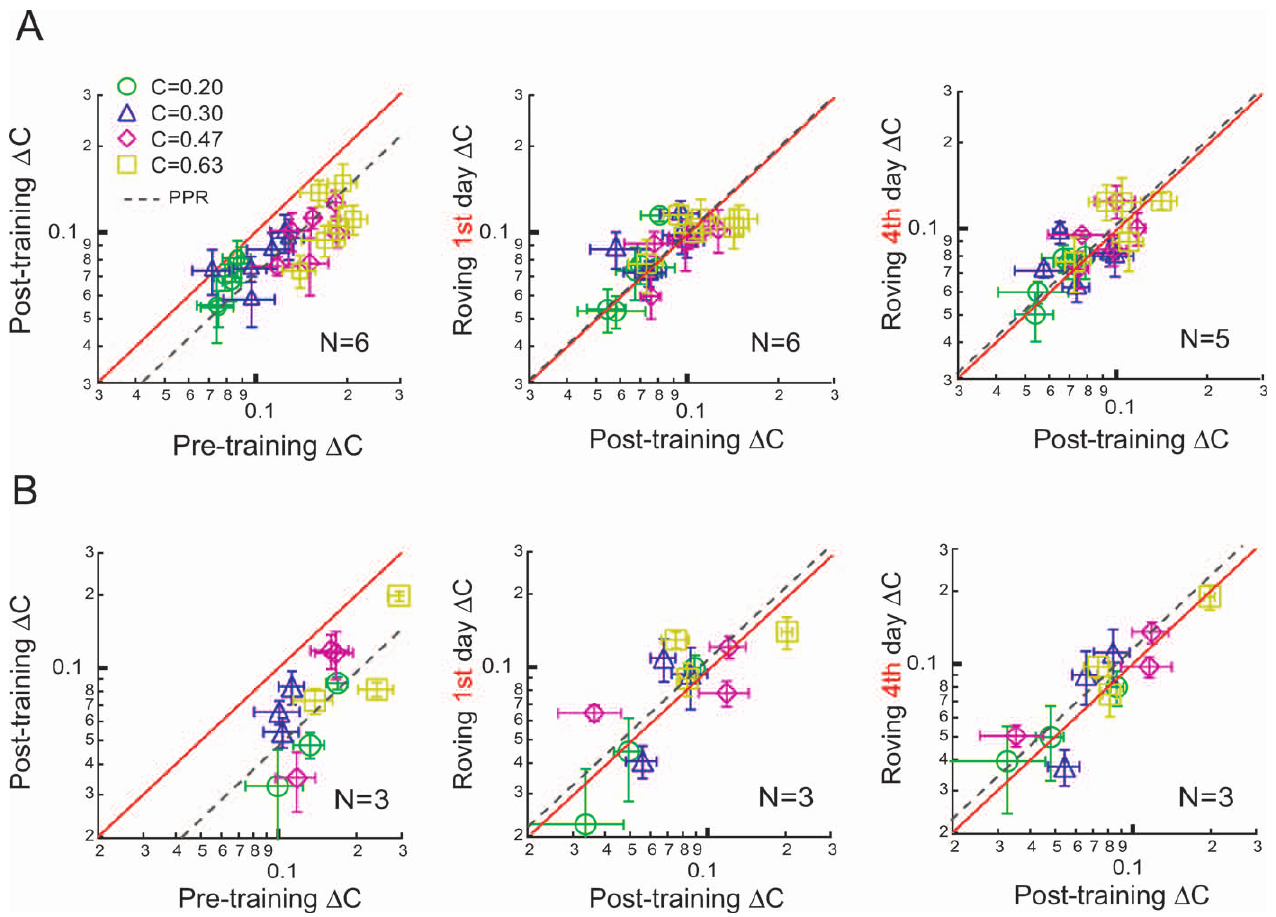
Figure 3. The Effects of Stimulus Roving After Learning (A) Stimulus roving immediately after completion of temporal-patterned training. The left panel shows pre- versus post-training thresholds. The middle panel shows first roving session versus post-training thresholds ( F 1,5 ¼ 0.24, p ¼ 0.647). Notice that the y -axis in the left panel becomes x -axis in the middle and right panels. The right panel shows the fourth (last) roving session versus post-training thresholds ( F 1,4 ¼ 0.49, p ¼ 0.520; only five observers finished all four roving sessions). (B) Same as (A) except that roving sessions started 2–4 wk after temporal-patterned training. The left panel shows pre- versus post-training thresholds. The middle panel shows first roving session versus post-training thresholds ( F 1,2 ¼ 0.46, p ¼ 0.570 ). Notice that the y -axis in the left panel becomes x -axis in the middle and right panels. The right panel shows the fourth (last) roving session versus post-training thresholds ( F 1,2 ¼ 2.36, p ¼ 0.264).